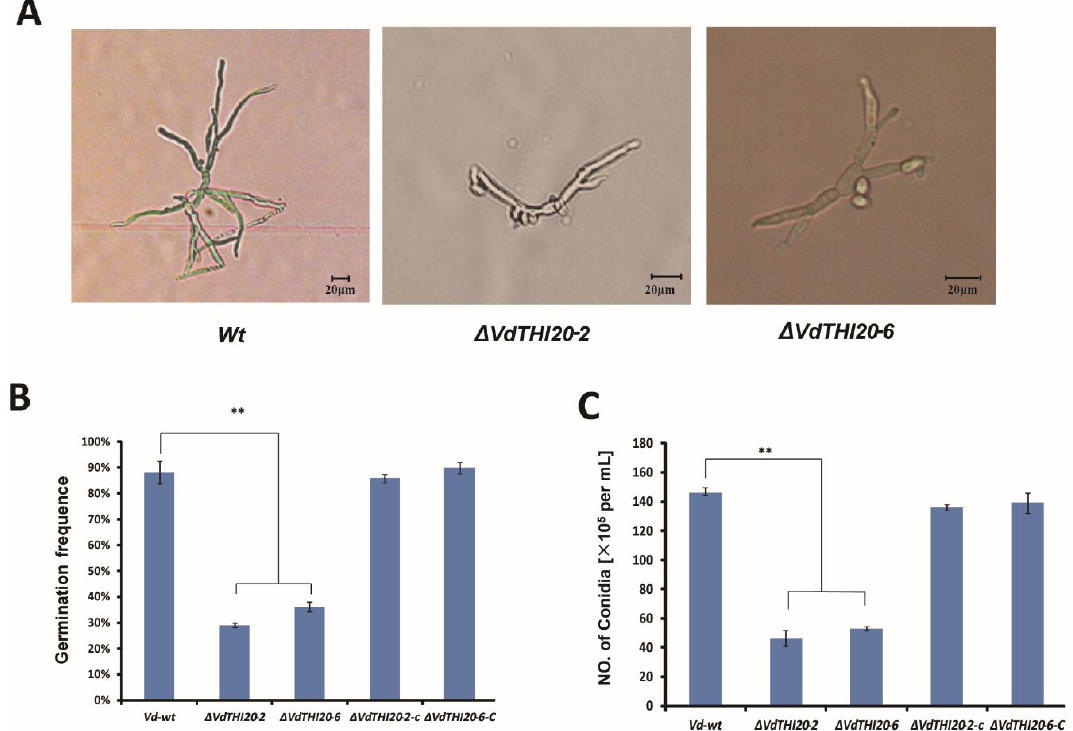
Figure 5. Deletion of VdTHI20 influences hyphal morphology, conidial germination and production. ( A ) Hyphae of each strain 24 h after germination in liquid CM broth. The hyphae of the ∆ VdTHI20 strains branched irregularly and did not form whorled branches. The hyphae of the ∆ VdTHI20 strains were also more swollen than those of Vd-wt . ( B ) Percentages of germinated conidia of Vd-wt , ∆ VdTHI20 mutant strains ( ∆ VdTHI20-2 and ∆ VdTHI20-6 ), and complemented strains ( ∆ VdTHI20-2-c and ∆ VdTHI20-6-c ) 30 h after inoculation in liquid CM. Reduced germination frequency of the ∆ VdTHI20 mutant strains in liquid CM in comparison with the Vd-wt strain is significant while the complemented ∆ VdTHI20 mutant strains in liquid CM in comparison with the Vd-wt strain is not significant at 30 h. ( C ) Number of conidia produced by the Vd-wt strain, ∆ VdTHI20 mutant strains ( ∆ VdTHI20-2 and ∆ VdTHI20-6 ), and complemented strains ( ∆ VdTHI20-2-c and ∆ VdTHI20-6-c ) after 15 days on Czapek–Dox agar plates. Decreased number of conidia produced by the ∆ VdTHI20 mutant strains the complemented strains on Czapek–Dox agar plates in comparison to the Vd-wt strain is significant and not significant after 15 days, respectively. Values represent the mean ± standard deviation from three independent replicates. Asterisks (**) indicate significant differences by Student’s t test at P < 0.01.